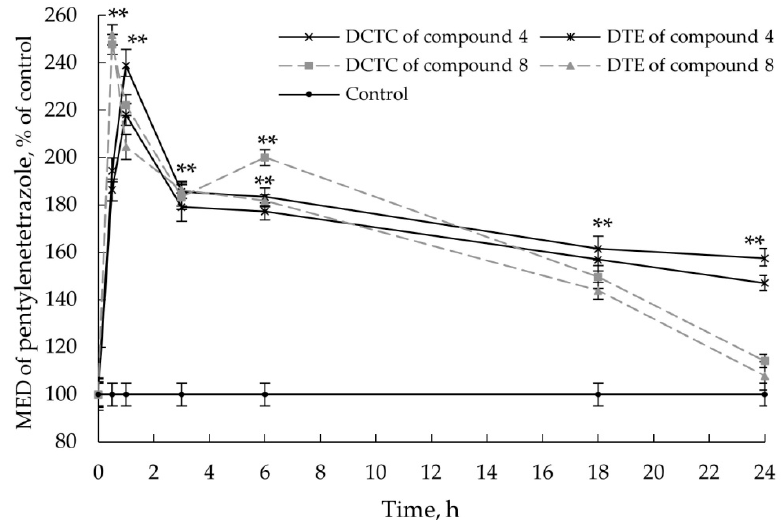
Figure 3. Anticonvulsant activity of compounds 4 and 8 ; time-response relationship. Values are given as mean ± SEM, n = 5 mice; ** p < 0.01 compared with vehicle control. One-way analysis of variance (ANOVA) followed by Tukey’s post hoc comparison.